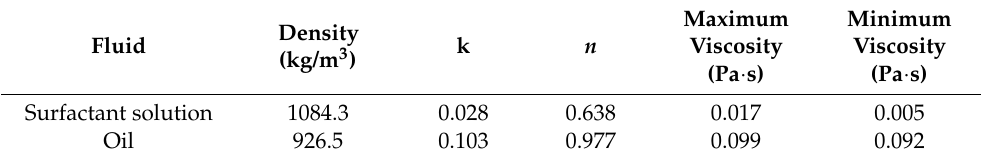
Table 5. Density and rheological parameters of the fluids used in the simulations. Minimum Maximum Density Viscosity k n Viscosity Fluid (kg/m 3 ) (Pa · s) (Pa · s) Surfactant solution 1084.3 0.028 0.638 0.017 0.005 Oil 926.5 0.103 0.977 0.099